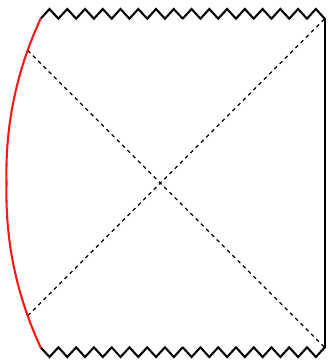
Figure 1 . Penrose diagram of an AdS black hole with the left asymptotic region terminating in an ETW brane (shown in red). The worldvolume geometry of the ETW brane is a big-bang/big- crunch